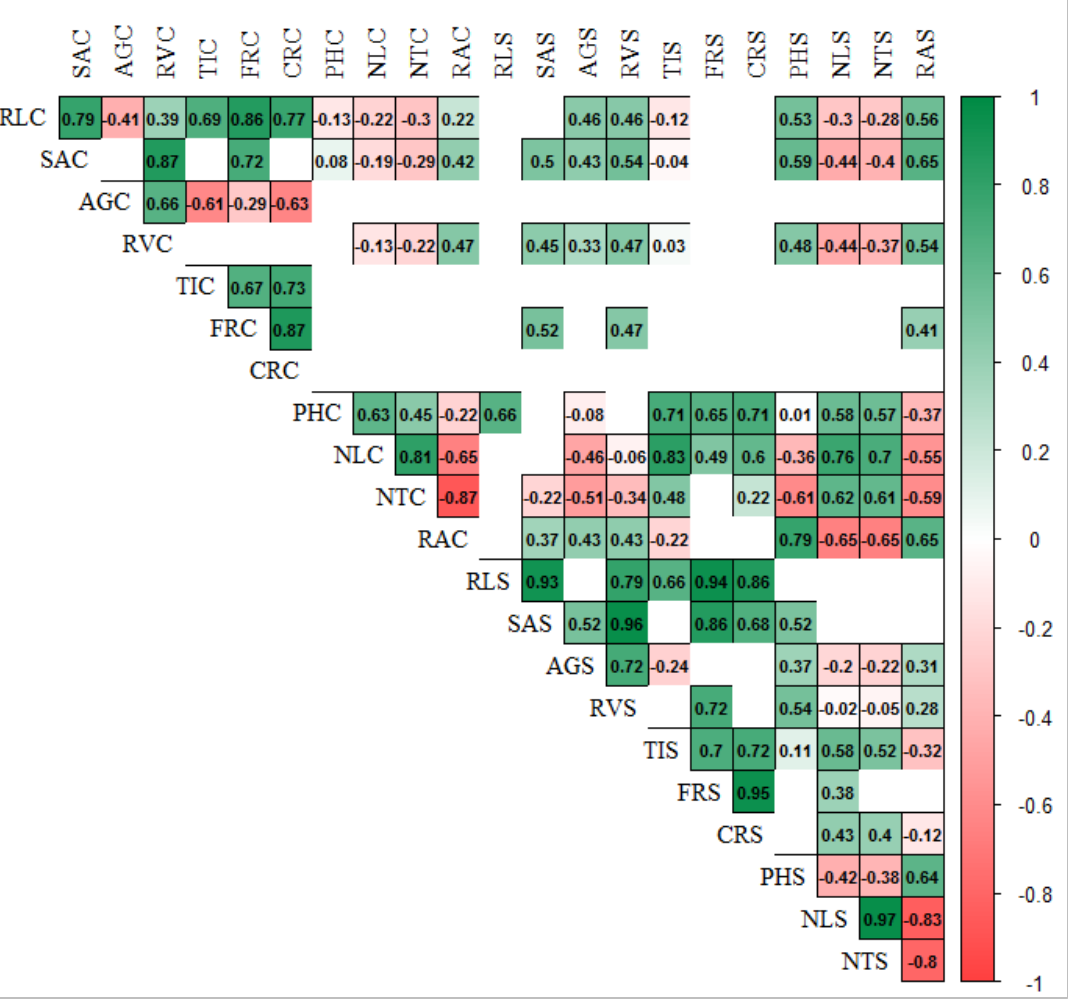
Figure 1. Correlation matrix among all the recorded traits in pots experiment under C-control and S-salt conditions. Positive (in green) and negative (in red) indicate significant ( p < 0.05) correlations. For abbreviations, please see the abbreviation list at the end of the